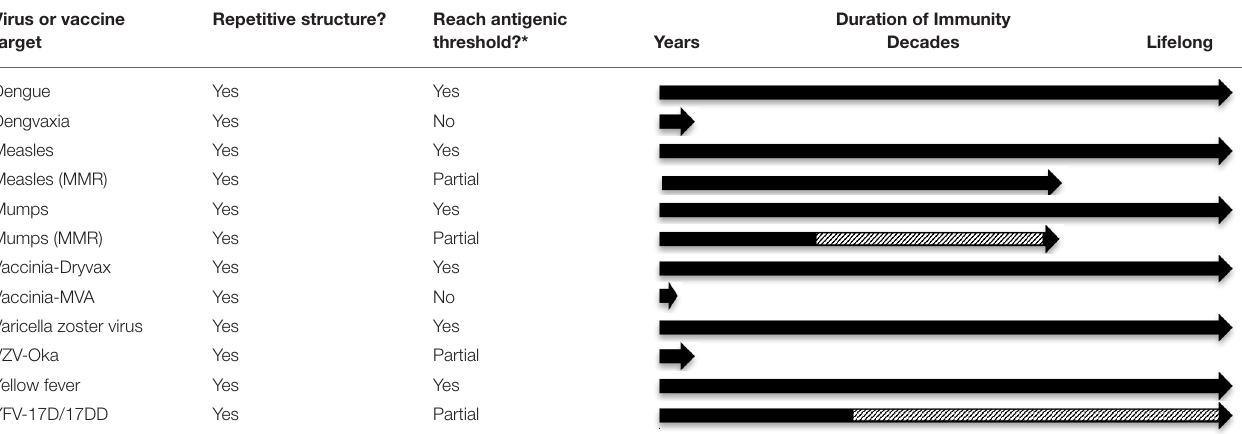
TABLE 1 | Examples of antiviral immunity generated from wild-type viruses vs. live-attenuated vaccine strains. Virus or vaccine